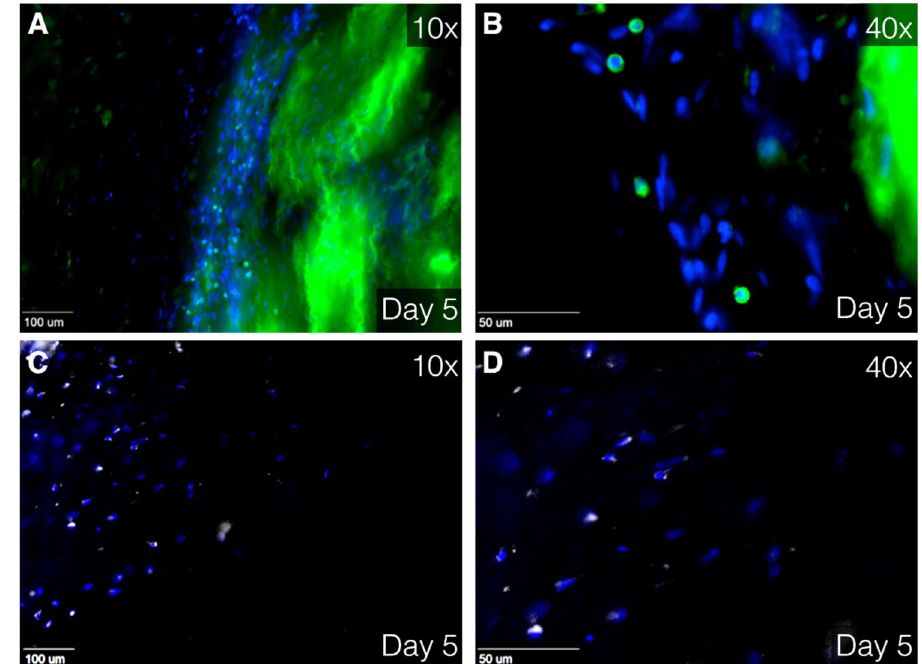
Figure 5. Immunofluorescence image at 10 × ( A , C ) and 40 × ( B , D ) magnification using Zeiss Axiovert 200 M Marianas ™ Microscope. Human tissue stained with DAPI (blue), CD45 (green, A , B ) and CD68 (white, C , D ) Green staining at the right side ( A , B ) is due to unintentional fluorescence of elastin. CD indicates cluster of differentiation and DAPI, 4 ′ ,6-diamidino-2-phenylindole.